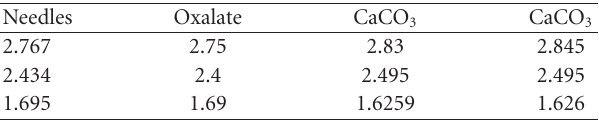
Table 1: D-spacing from electron di ff raction of needles from Codium minus and for calcium oxalate [19] and standards (JCPDS, 1986) for calcium carbonate as calcite (24–27C;